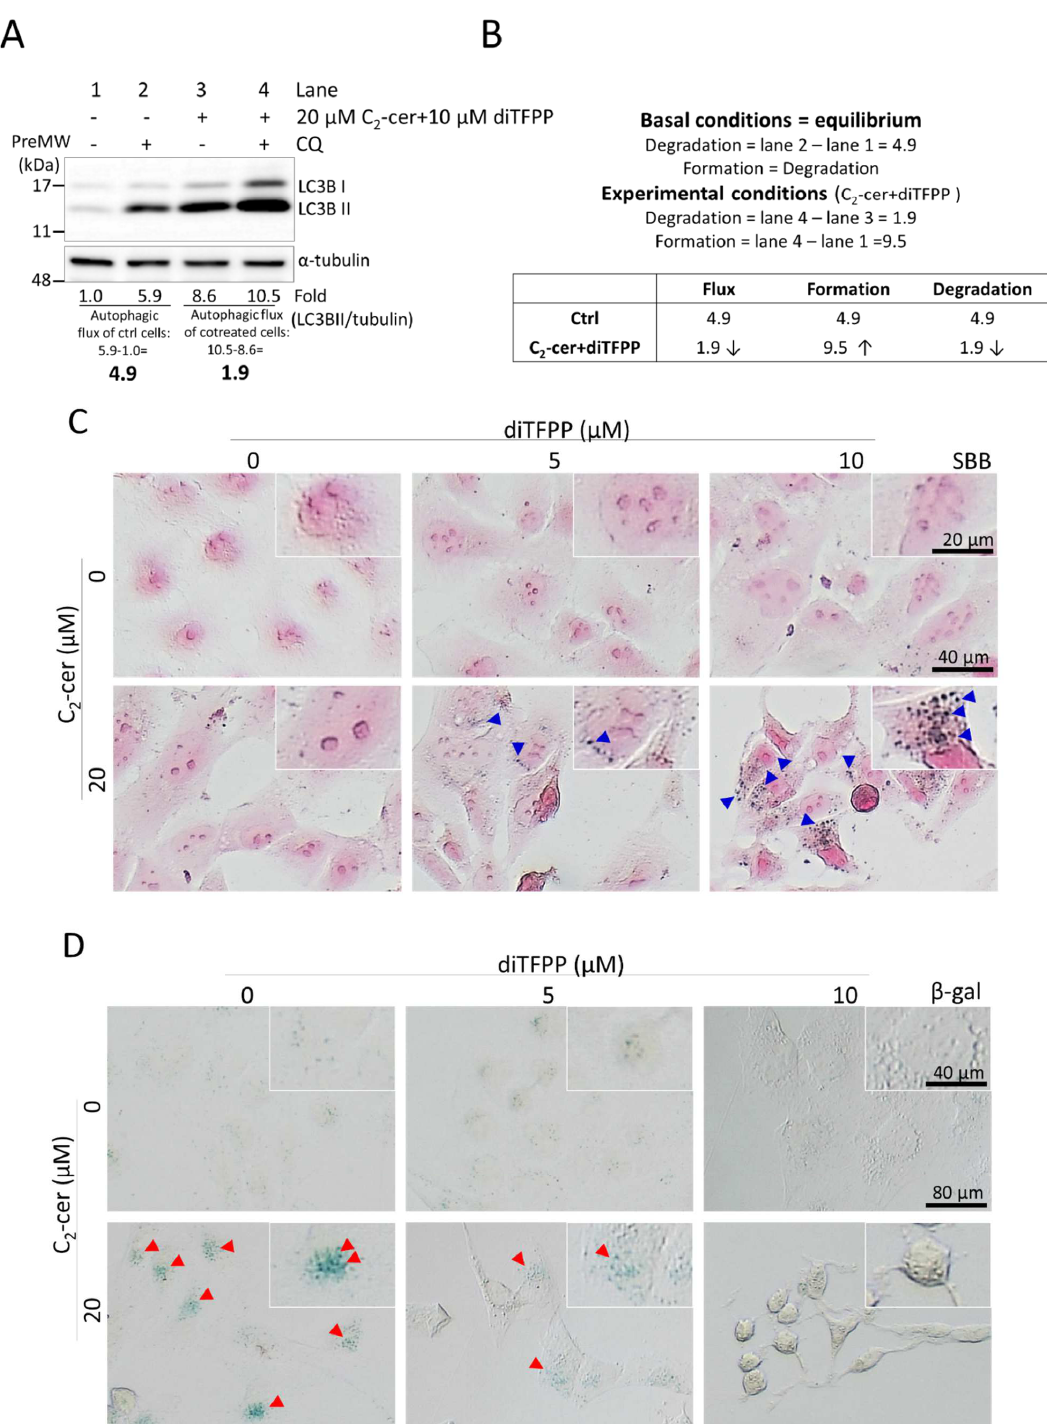
Figure 4. Assessment of autophagic flux after diTFPP/C 2 -ceramide treatment for 24 h. ( A ) Au- tophagic flux was assessed by measuring the level of LC3B II protein remaining after CQ treatment (see Section 3.4). ( B ) Quantitative results of experiments (with and without C 2 -ceramide/diTFPP) in